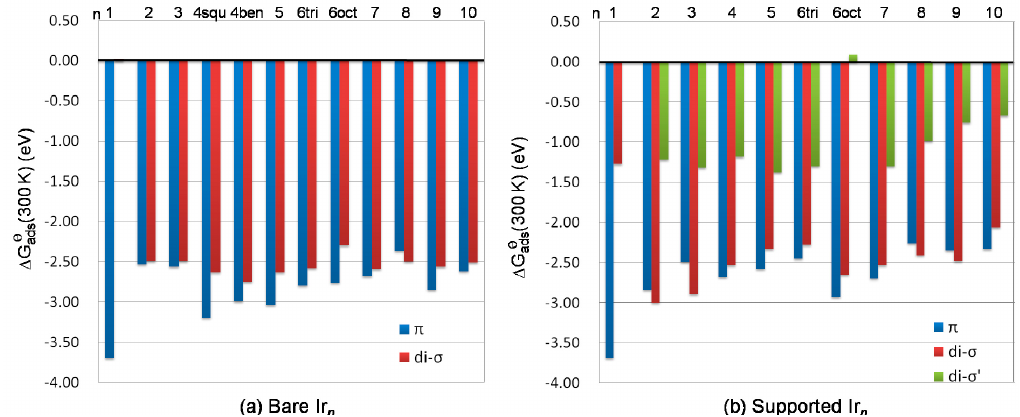
Figure 6. Standard adsorption Gibbs free energy at 300 K; ∆ G q ads (300 K) of ethylene adsorption on (a) bare Ir n clusters and (b) hydrated (110) γ -Al 2 O 3 -supported Ir n clusters.